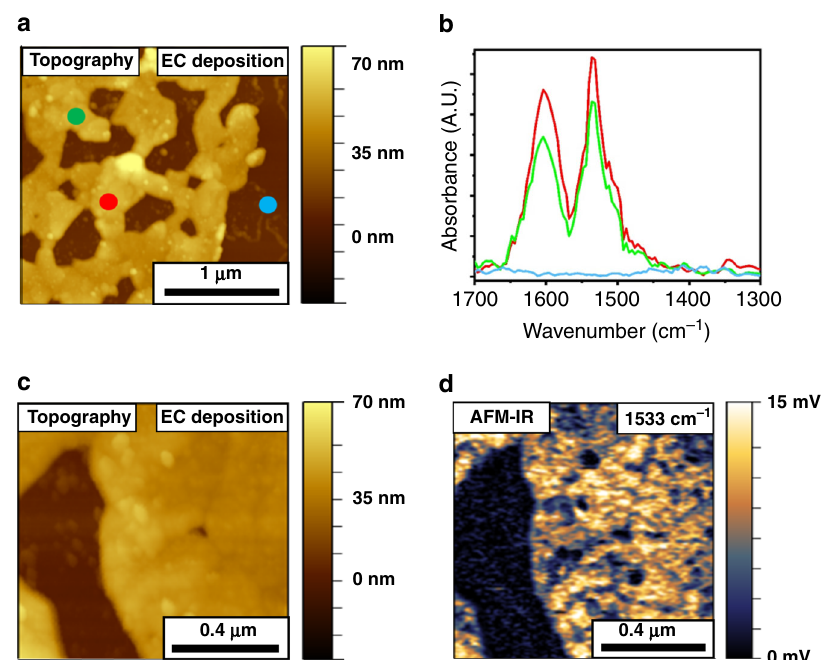
Fig. 4 AFM-IR measurements of EC-deposited NO 2 -NHCs on Au fi lm. AFM topography ( a ) and AFM-IR point spectra measurements ( b ) following EC deposition of NO 2 -NHCs on a patchy Au fi lm that was deposited on Si electrode. Colored circles in a mark the local IR measurement positions and the measured IR spectra are shown in b with identical color-coding. AFM topography image at higher magni fi cation and the corresponding AFM-IR image at 1533 cm − 1 are shown in c and d ,